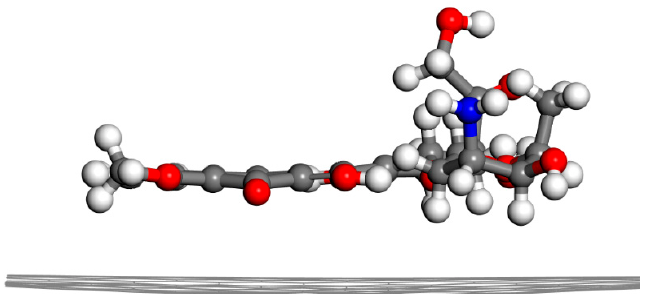
Figure 4. Energy-minimized structure of G-DOX (side view).